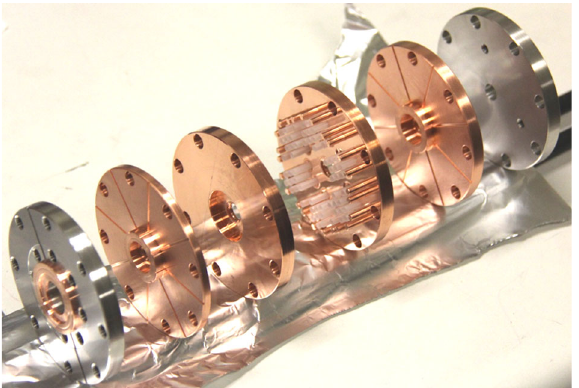
FIG. 5. Machined components of the HPBG structure, includ- ing (left to right) the input flange with a copper gasket; the input coupling cell; the upstream HPBG cell plate; the downstream HPBG cell plate with 60 sapphire rods and 20 copper rods inserted; the output coupling cell; and the output flange. The flanges are made of stainless steel and the others are